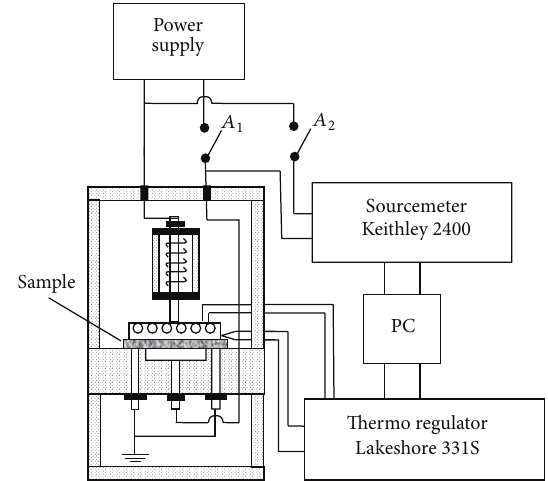
Figure 2: Schematic diagram of measurement system for